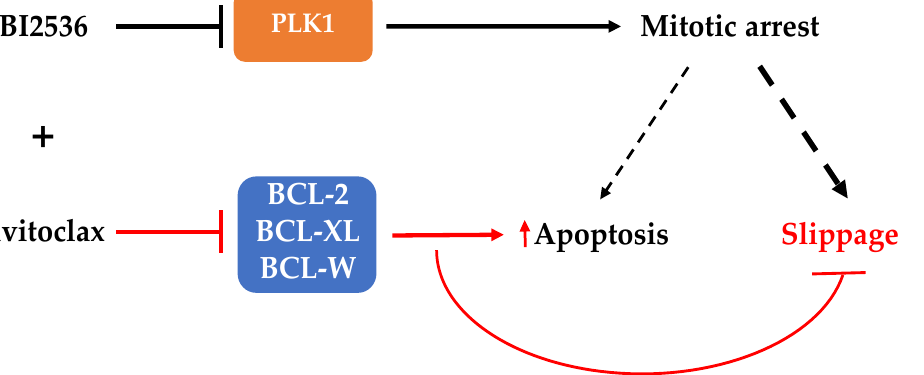
Figure 7. Model for the effects of the combination of PLK1 inhibition and Navitoclax in human lung cancer cells. Cancer cells arrested in mitosis under individual treatment with PLK1 inhibitor BI2536 can die in mitosis by apoptosis, or exit mitosis by slippage, the most frequent cell fate (larger dashed line). The addition of Navitoclax (+), an inhibitor of the indicated BCL-2 family members, can synergistically potentiate BI2536-mediated apoptosis during the mitotic arrest and, thus, prevents mitotic slippage, highlighting the therapeutic potential of targeting PLK1 in combination with an apoptotic inducer. Black and red lines represent the BI2536 and Navitoclax effects, respectively. Supplementary Materials: The following supporting information can be downloaded at: